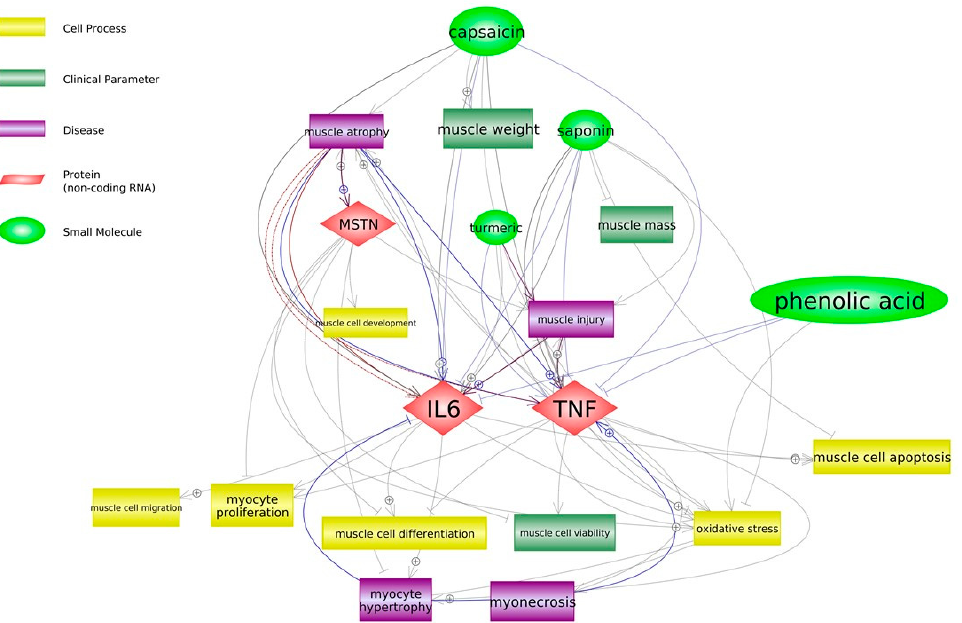
Figure 1. Potential effect of bioactive ingredients of phytobiotic composition on muscle tissue in broiler chickens (Pathway Studio ® Mammal Plus, Elsevier).